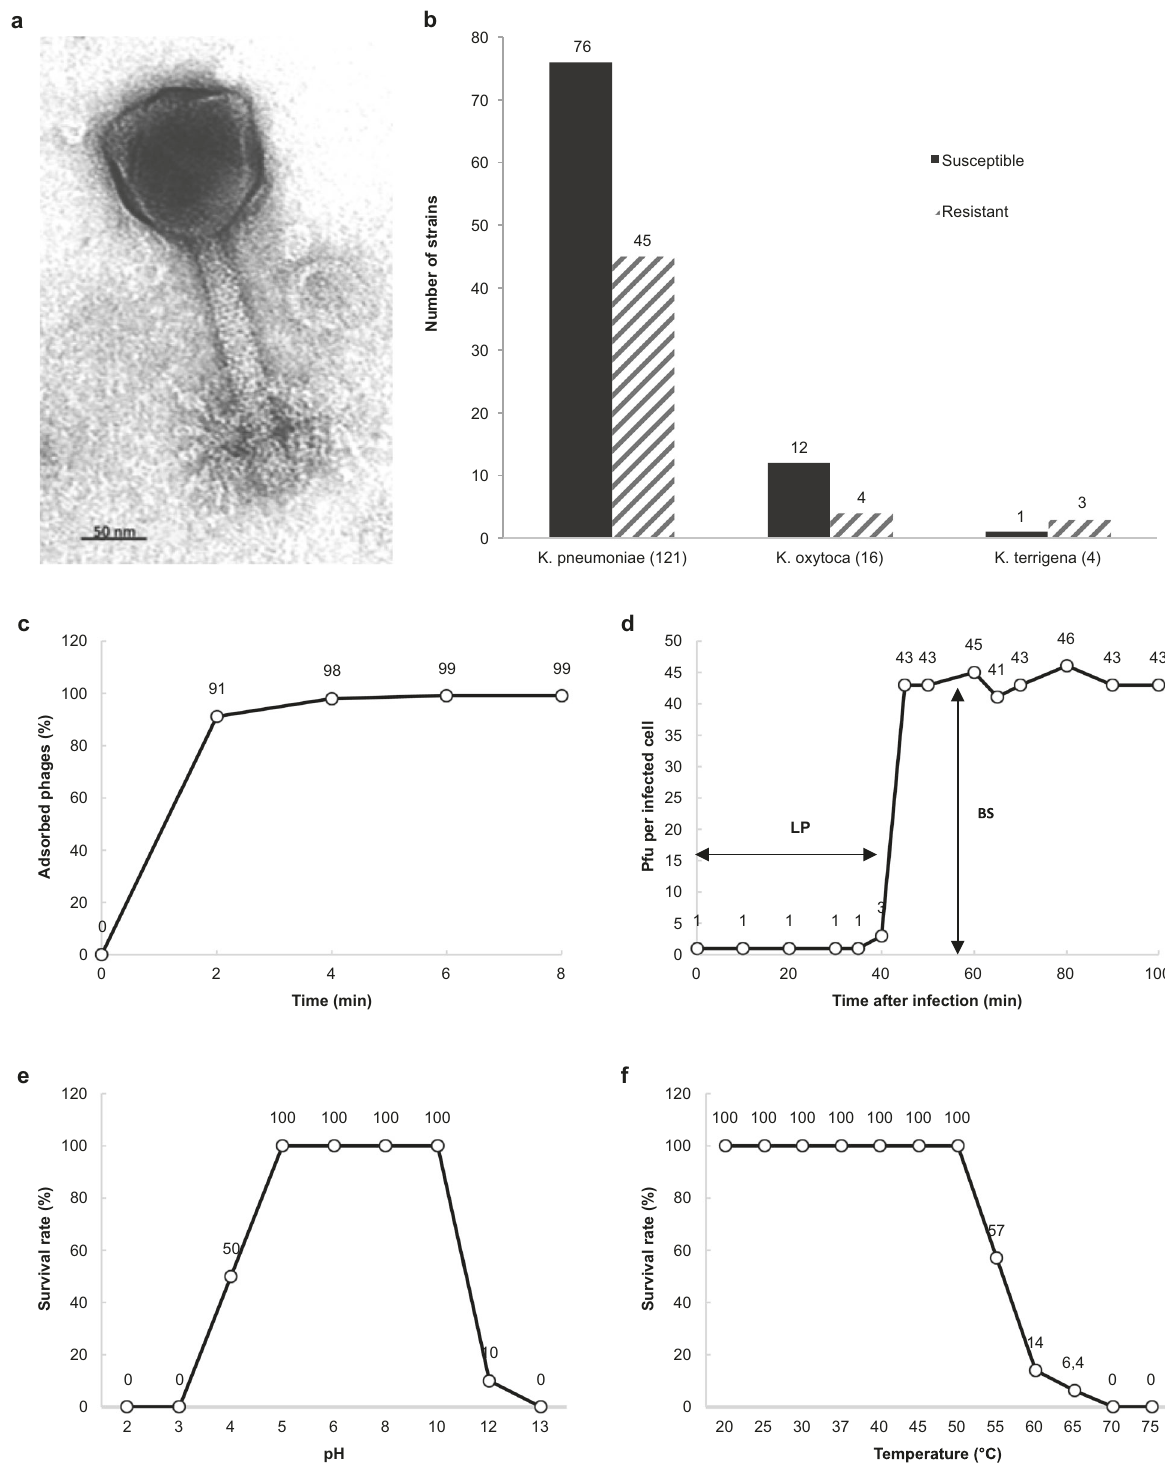
Fig. 2 Characteristics of phage M1. Transmission electron micrograph showing an icosahedral head (120 × 120 nm) and a contractile tail (150 × 22 nm) ( a ). Lytic activity of phage M1 against 141 Klebsiella spp. clinical isolates obtained from Georgia ( n = 88), France (22), Switzerland (21), Singapore (6), and China (4) ( b ). Biological characteristics of phage M1 as determined in propagation strain 1a. Adsorption curve ( c ), single-step growth curve ( d ), pH stability ( e ), and temperature stability ( f ). BS, burst size; LP, latent period; PFU, plaque-forming unit. Source data are provided as a Source Data fi